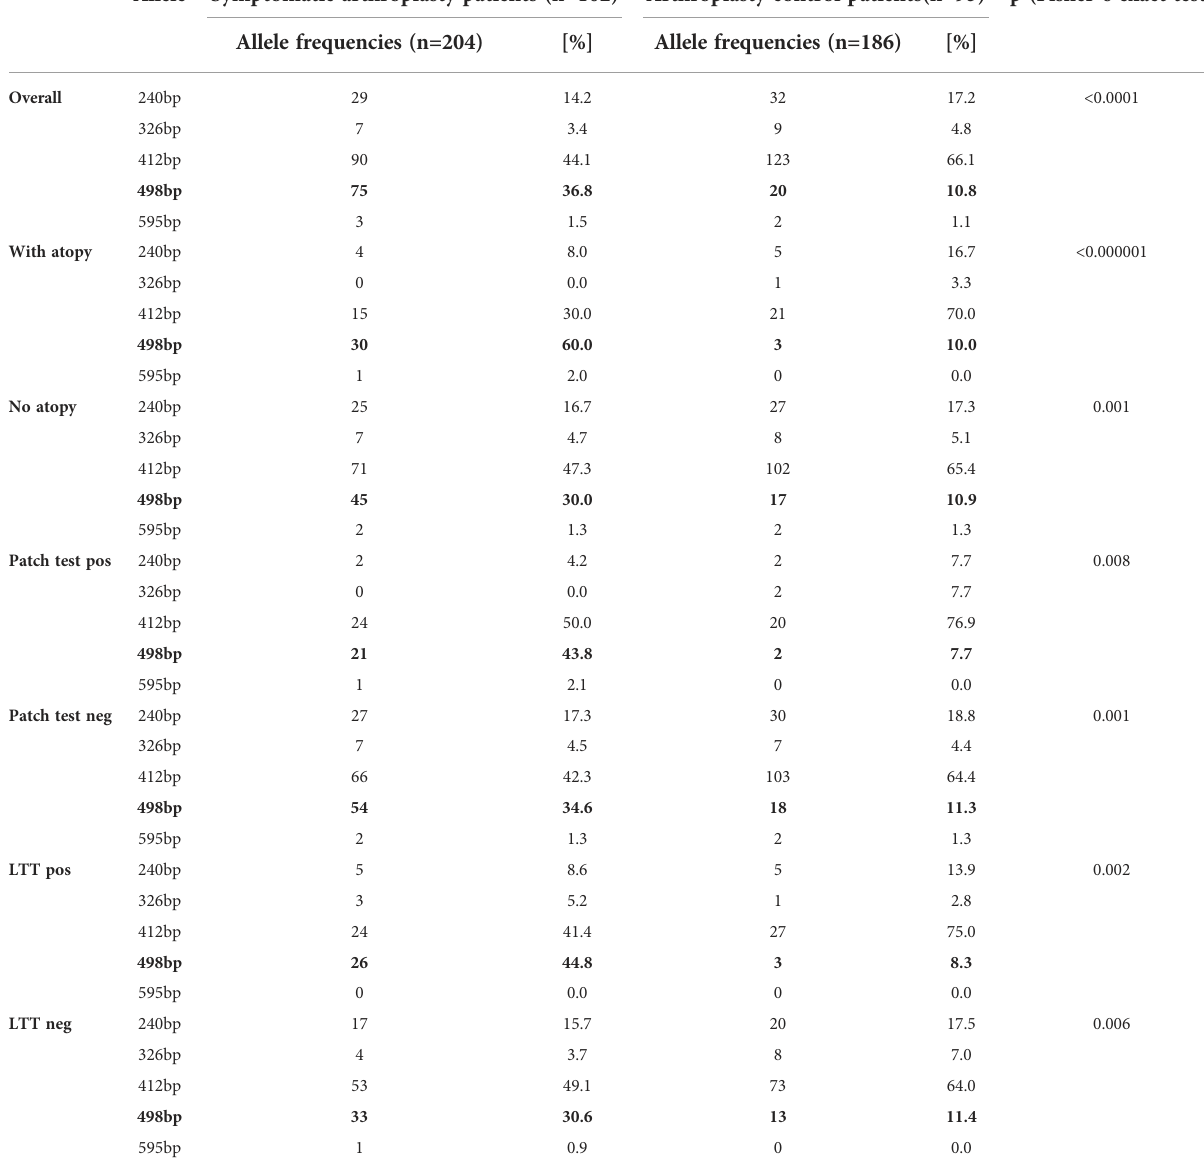
TABLE 7 Allele frequencies of the IL-1RN Intron 2 VNTR polymorphism including also subgroup analysis. Allele Symptomatic arthroplasty patients (n=102) Arthroplasty control patients(n=93) p (Fisher´s exact